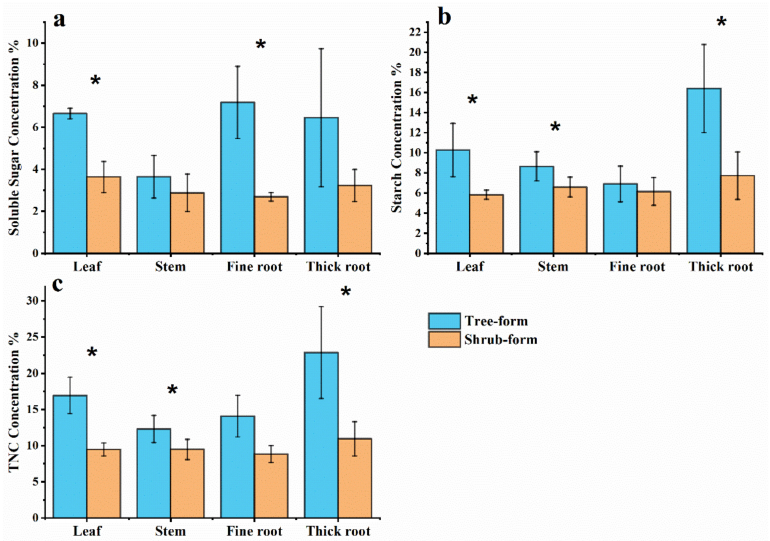
Figure 4. Effects of growth form on NSC concentration in seedlings. Changes of ( a ), soluble sugar, ( b ), starch and ( c ), TNC concentration of each organ. Asterisks indicate that MANOVA shows significant differences between different growth form trees (*, p < 0.05).